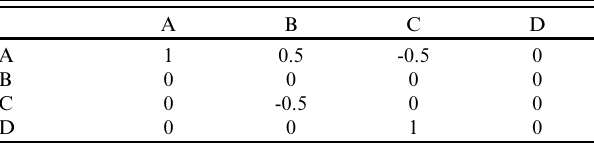
Table 1 . Adjacency matrix derived from the fuzzy cognitive map of Figure